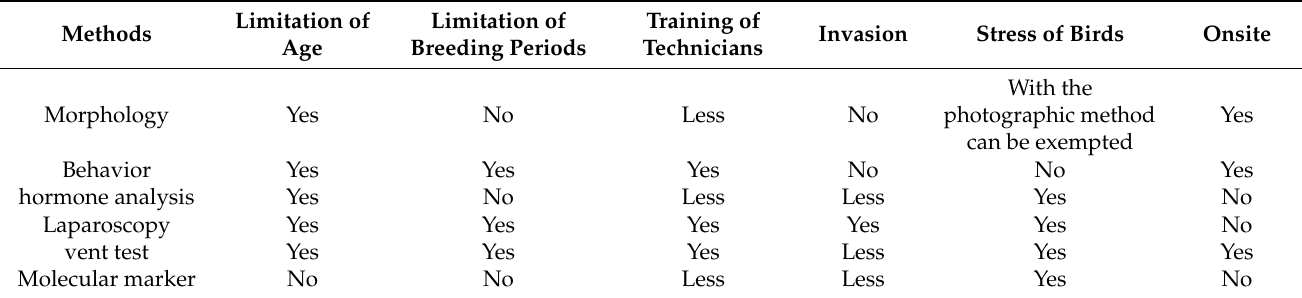
Table 1. Comparison of sexing methods used for monomorphic